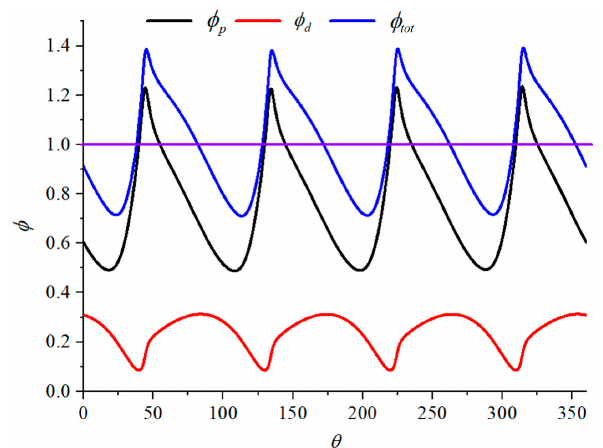
Figure 13. Distribution of impeller inlet energy head coefficient at different radial coefficient at A 3.